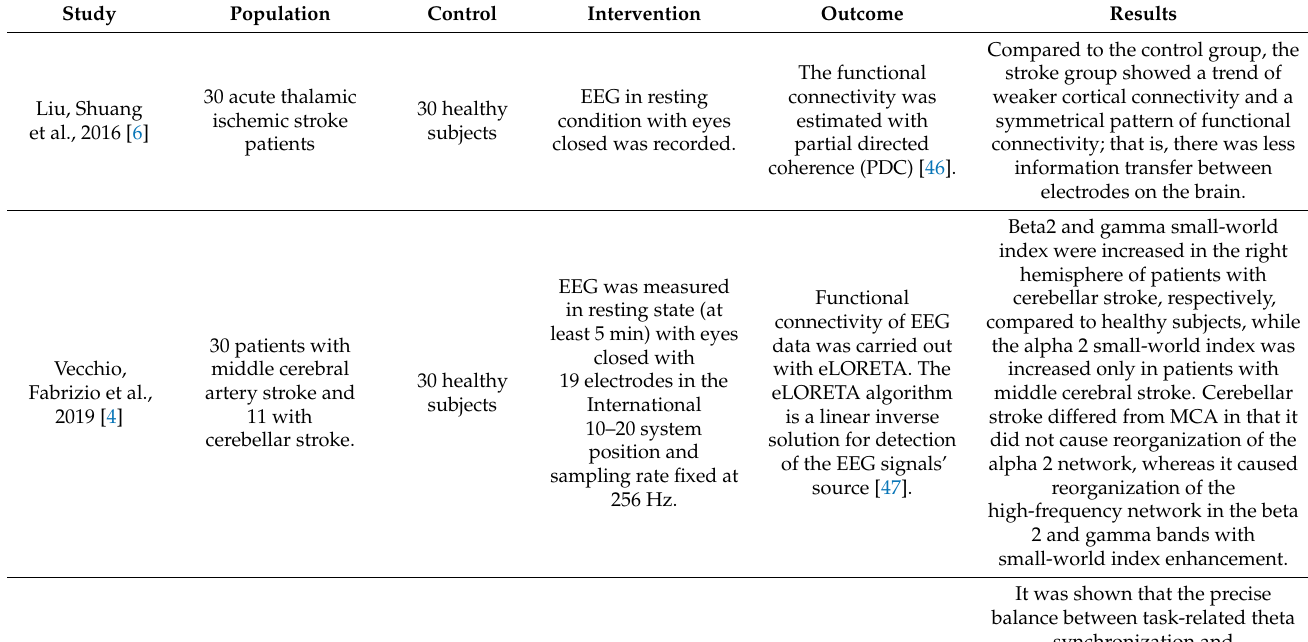
Table 1. Data of the studies investigating the analysis of brain networks in stroke